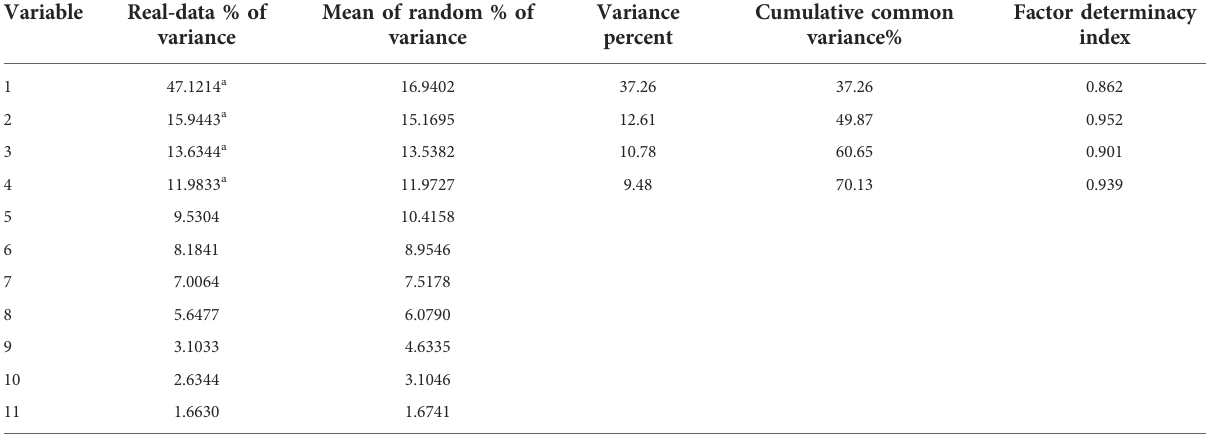
TABLE 2 Output from optimal parallel analysis based on Minimum rank factor